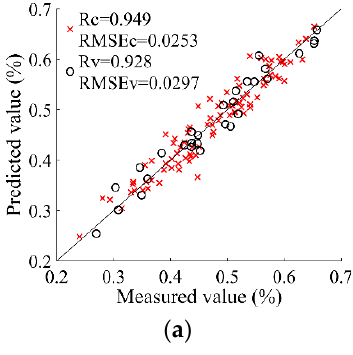
Figure 6. Scatter plot of the calibration set (×) and verification set (o) of stone cell content. ( a ) SPA; ( b ) MCUVE.